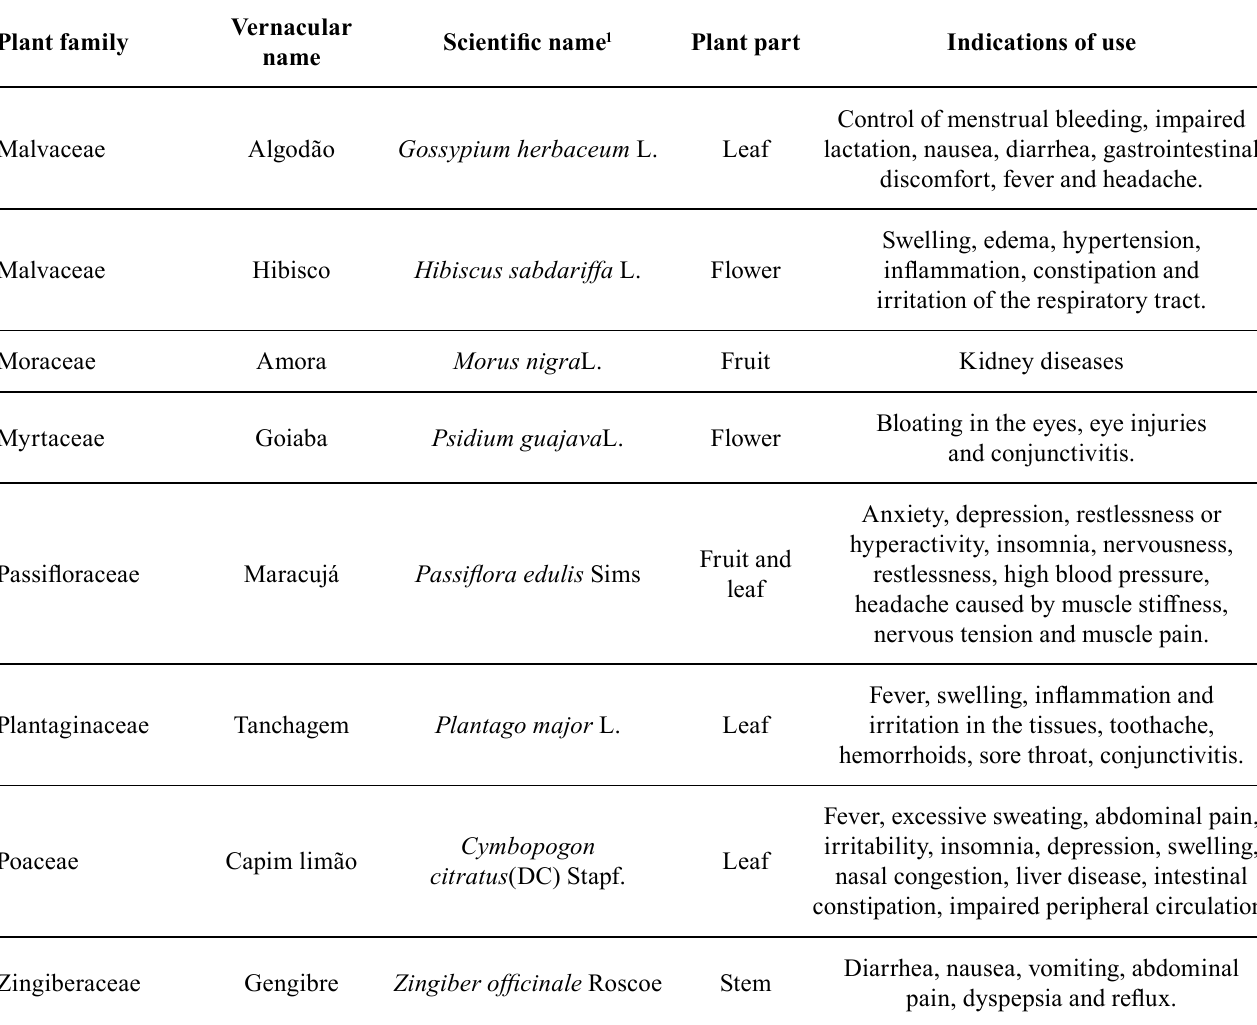
TABLE III – Correlation of the ethnospecies mentioned by the respondents (vernacular name) with the corresponding families, species, plant part and indications of use cataloged in The Plant List (2013). Bold letters indicate the most cited plant species